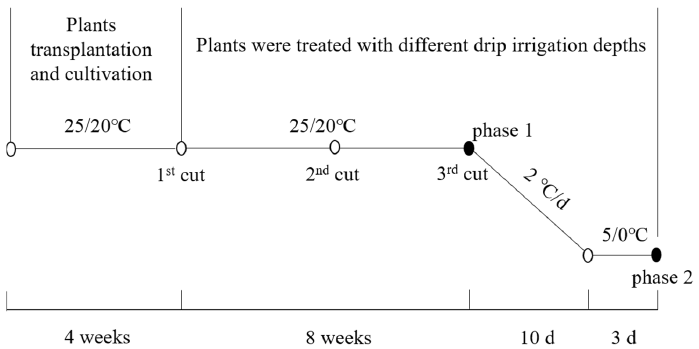
Figure 1. Schematic diagram of the experimental and sampling process.